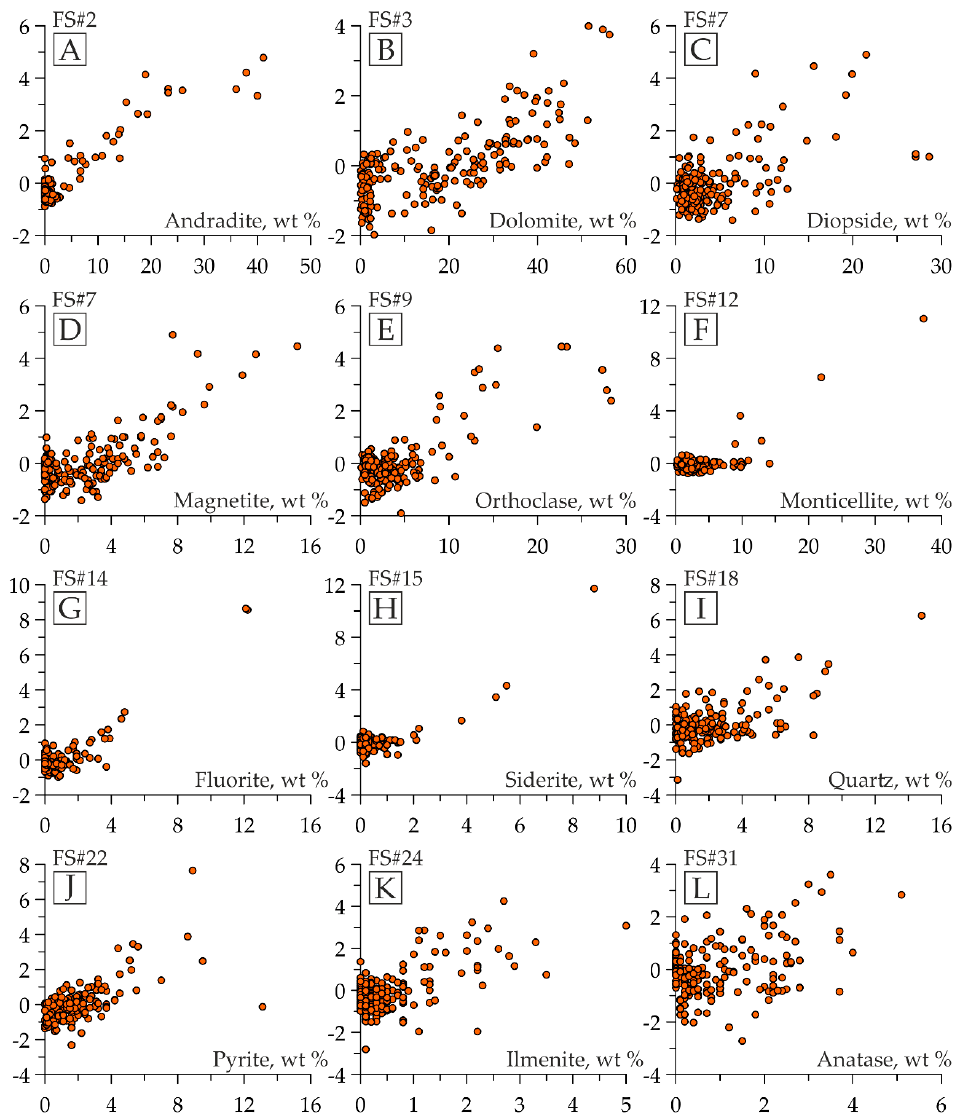
Figure 2. Examples of the functional relationships between factor scores ( FS ) and semiquantitative estimates of the mineral contents. Factor numbers are shown after the “#” symbol.